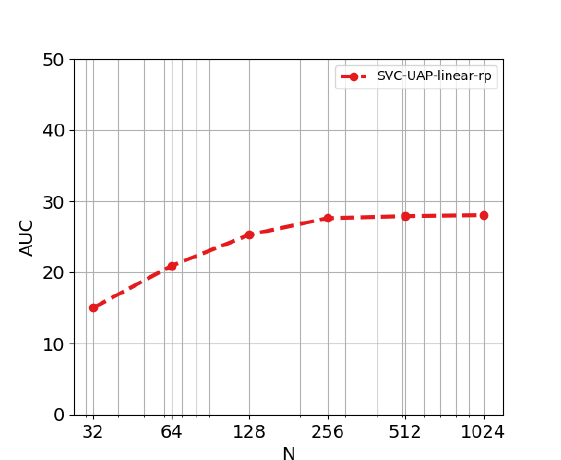
Figure 6. Evolution of AUC of AR-AN curve when N increases.